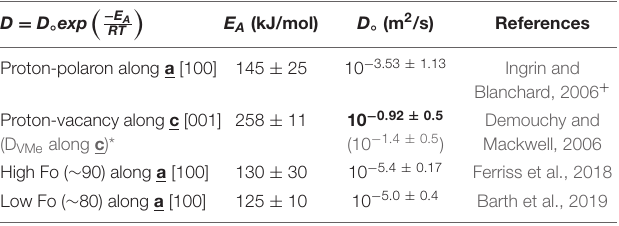
TABLE 1 | Arrhenius relationships along the fast diffusion direction for different diffusion mechanisms and olivine forsterite (Fo) content. (cid:16) − E A D = D ◦ exp RT